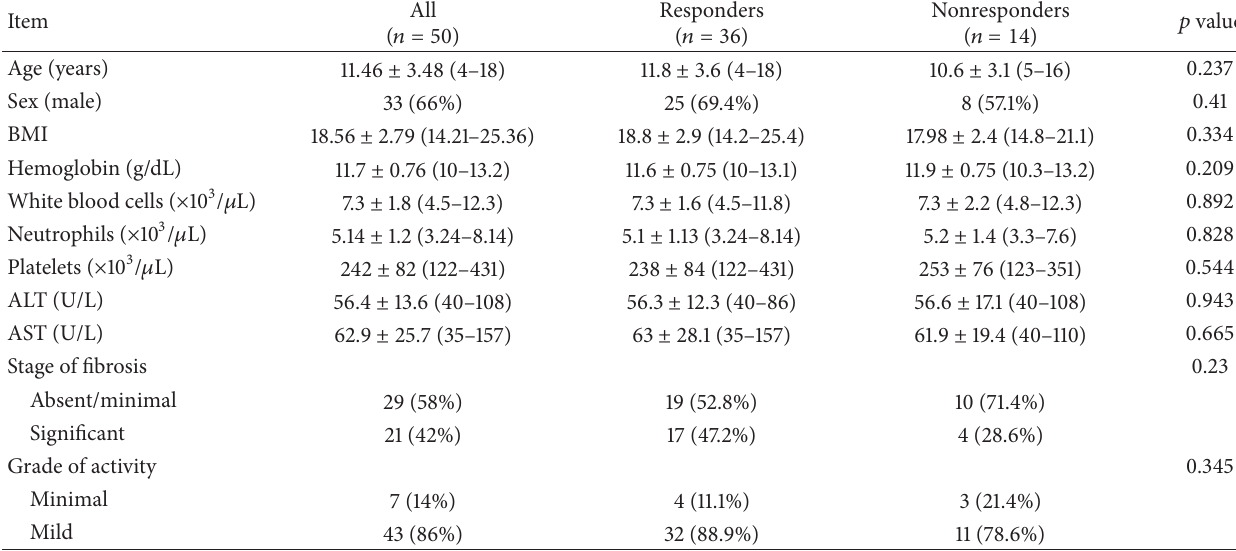
Table 1: Baseline demographic, laboratory, and histopathological characteristics of the hepatitis C virus-infected